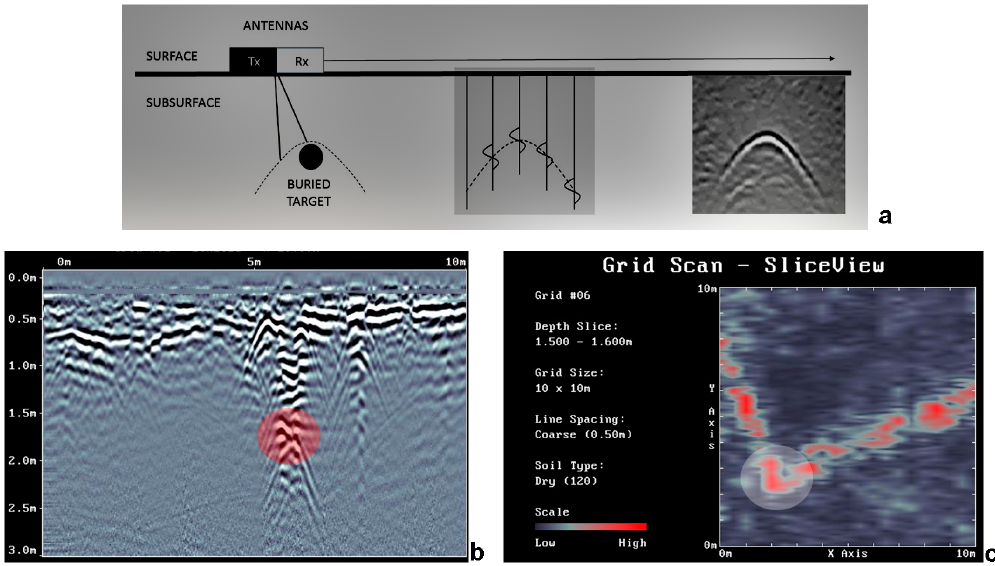
Figure 3. The upper image shows geometry of the most common mode of GPR data acquisition, referred to as “reflection mode” coverage. In ( a ), single transmitter (Tx) and receiver (Rx) antennae are transported over the ground surface in a fixed configuration above a buried target, resulting in hyperbolic time-distance behavior. The lower images show, in ( b ), a typical radargram (B-scan or GPR section). In ( c ), the relative depth map (C-scan or GPR depth-slice).